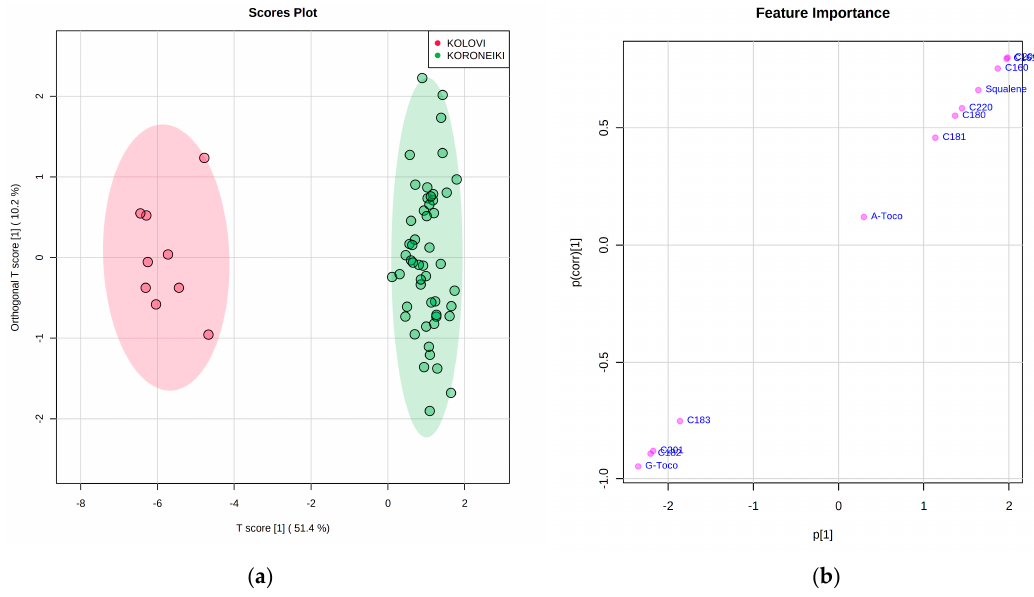
Figure 4. ( a ) Orthogonal Partial Least Squares Discriminant Analysis (OPLS-DA) score plot for the cultivar of EVOOs. The legend indicates the two cultivars tested, and the colored areas represent the 95% confidence region; ( b ) S-plot visualizing the variable influence in the model.